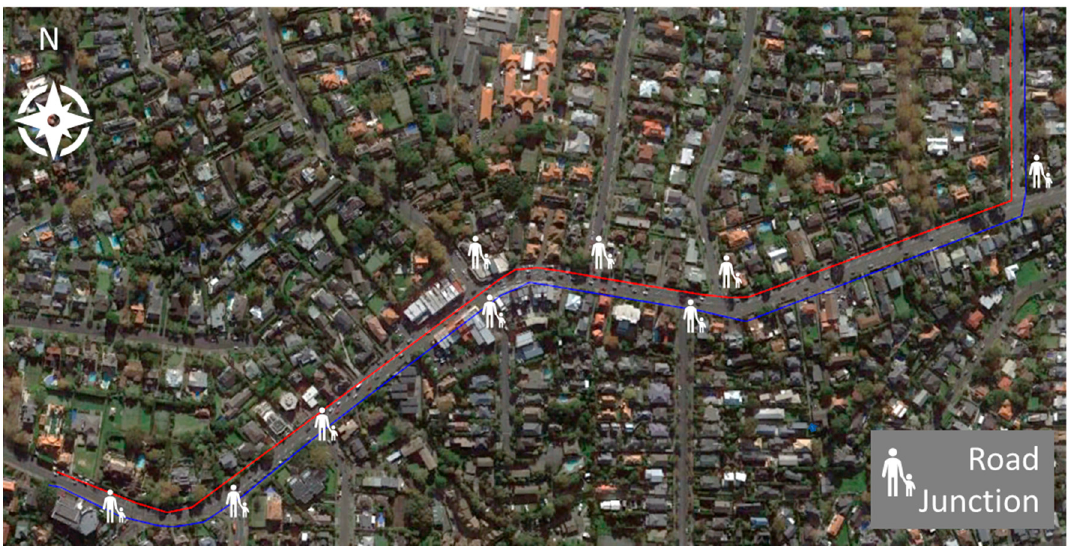
Figure 6. WSB (Walking School Buses) route. The red line shows the north side of the footpath and the blue line shows the south side of the footpath. The places where pedestrians have to cross roads are shown.